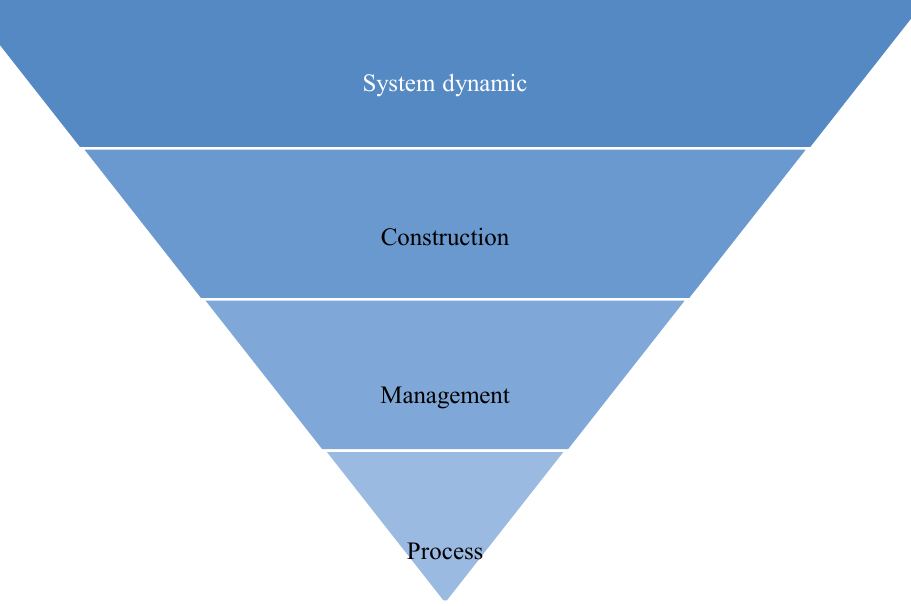
Fig. 3. Basic module of systematic literature